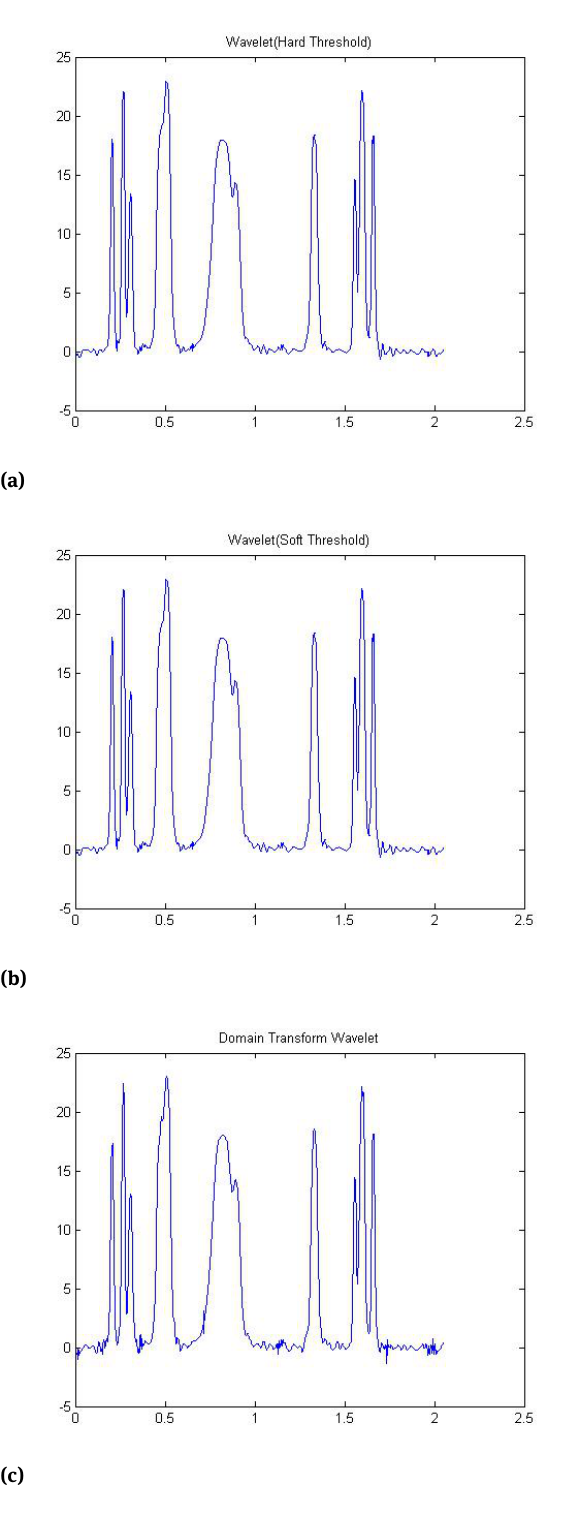
Figure 2: De-noising Results for the Bump signal. (a) Hard threshold (b) Soft threshold (c) Domain-Wavelet (Hard threshold) (d) Domain- Wavelet (Hard threshold).